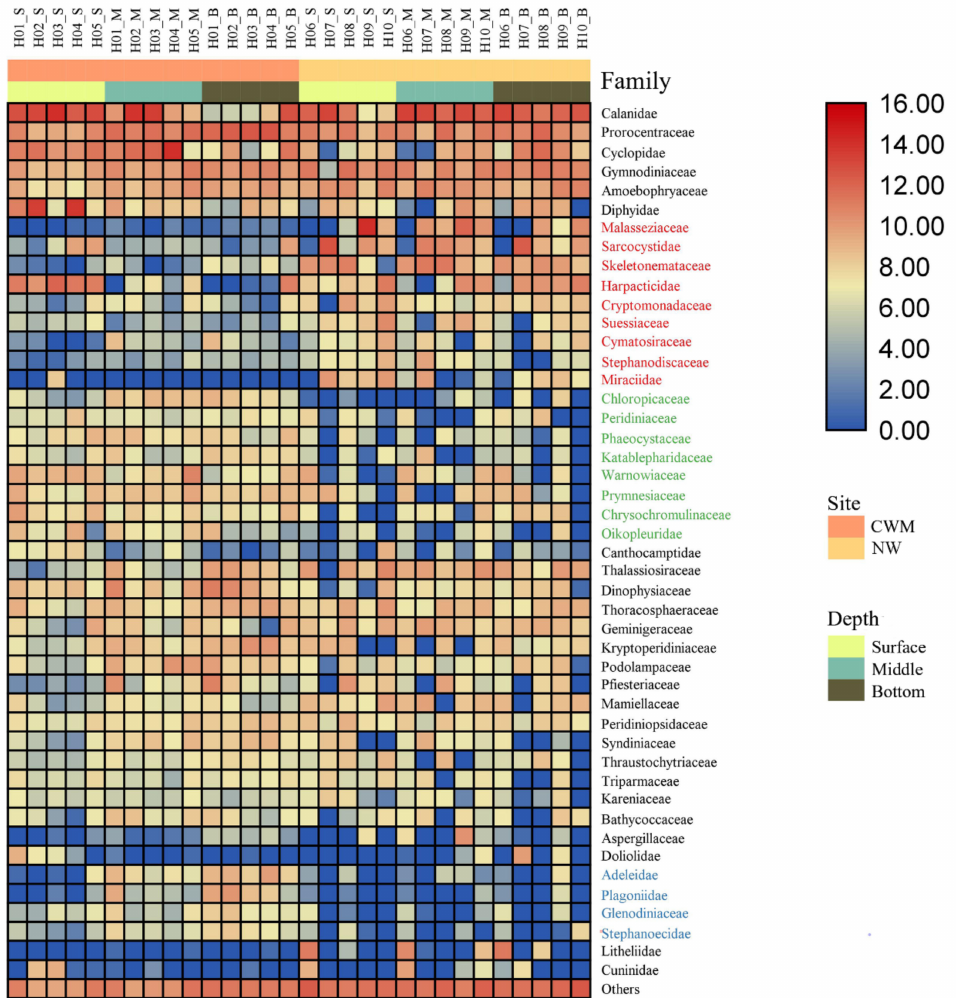
Figure 4. Unweighted pair group method with arithmetic mean (UPGMA) and heatmap of eukaryotic plankton families with relative abundances across different samples. Colors indicate taxa with a higher (red) or lower (blue) relative abundance in each sample. Cold Water Mass (CWM) populations (H01_S–H05_S: surface; H01_M–H05_M: middle; H01_B–H05_B: bottom); nearshore waters (NW) populations (H06_S–H10_S: surface; H06_M–H10_M: middle; H06_B–H10_B: